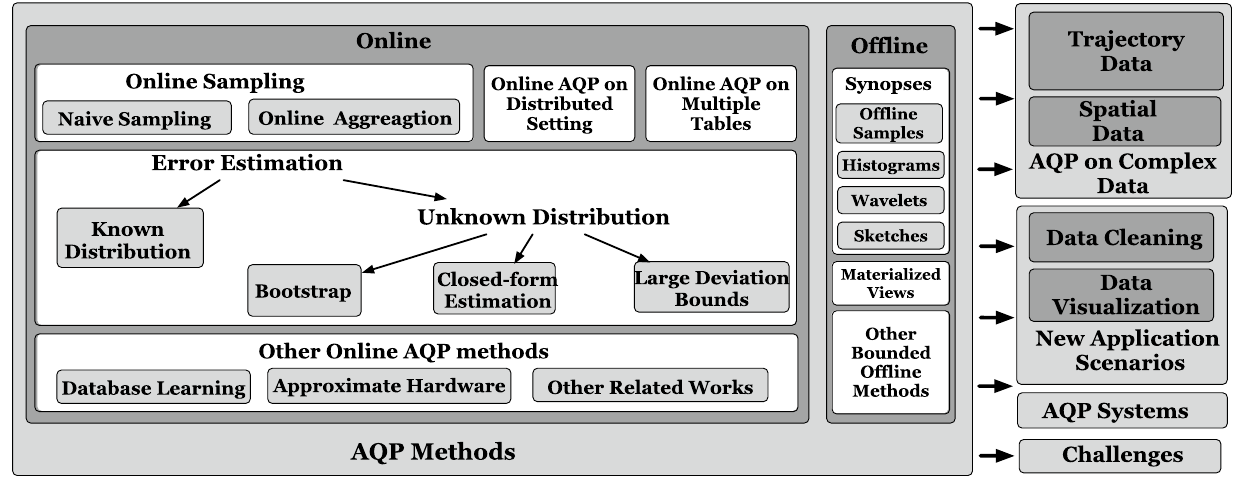
Fig. 2 AQP overview Table 1 Comparison of existing AQP